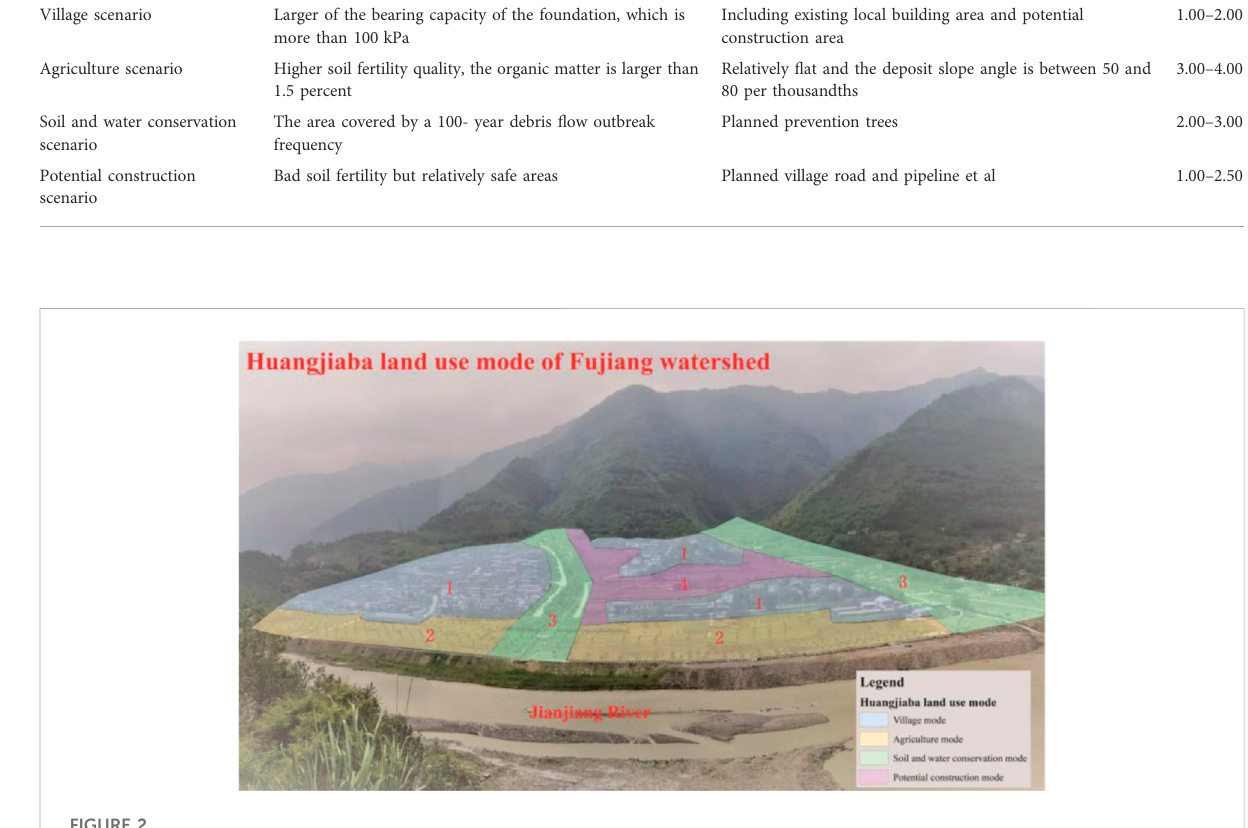
FIGURE 2 The diagram of Huangjiaba four land-use